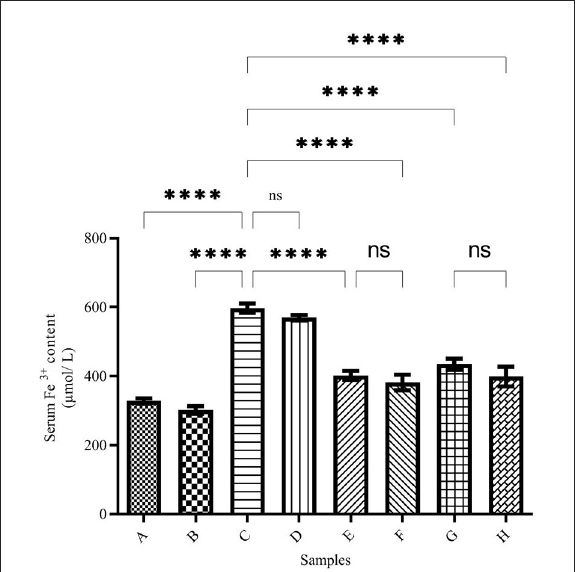
FIGURE1 Serum Fe 3 + content in the treated mice. Group A: control group, normal saline-receiving group; Group B: normal saline and desferal (DFO)-receiving group; Group C: iron dextran and normal saline-receiving group; Group D: iron dextran and DFO-receiving group; Group E: low dose caffeic acid-receiving group (30 mg/kg/day); Group F: high dose caffeic acid-receiving group (50 mg/kg/day); Group G: low dose ferulic acid-receiving group (30 mg/kg/day); and Group H: high dose ferulic acid-receiving group (50 mg/kg/day) (Mean ± SD; ns, non-significant and **** p ≤